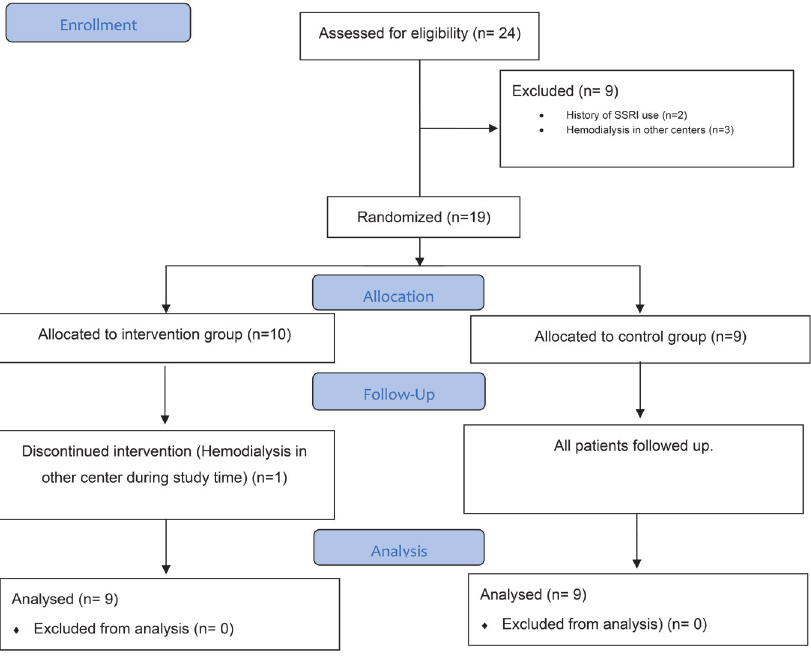
Figure 1. Flowchart of enrollment and random assignment of study participants.